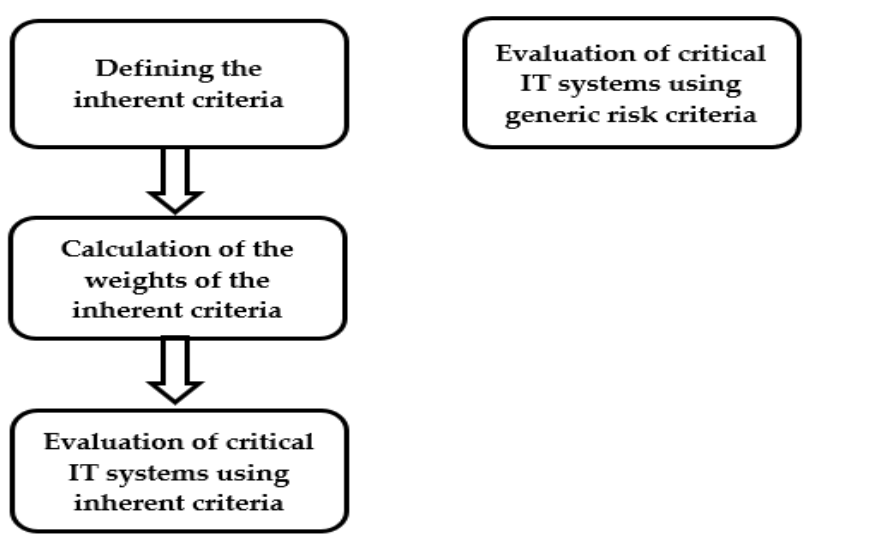
Figure 7. Evaluation steps.